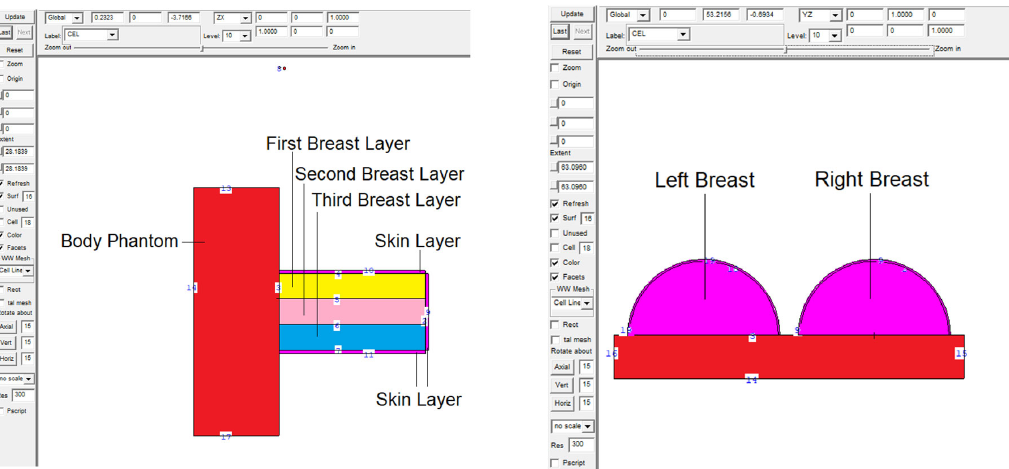
Figure 1. Tw o − dimensional view of modelled breast phantom in MCNPX code. Figure 1. Two − dimensional view of modelled breast phantom in MCNPX Table 1. Elemental properties and densities of the modelled breast layers [27].